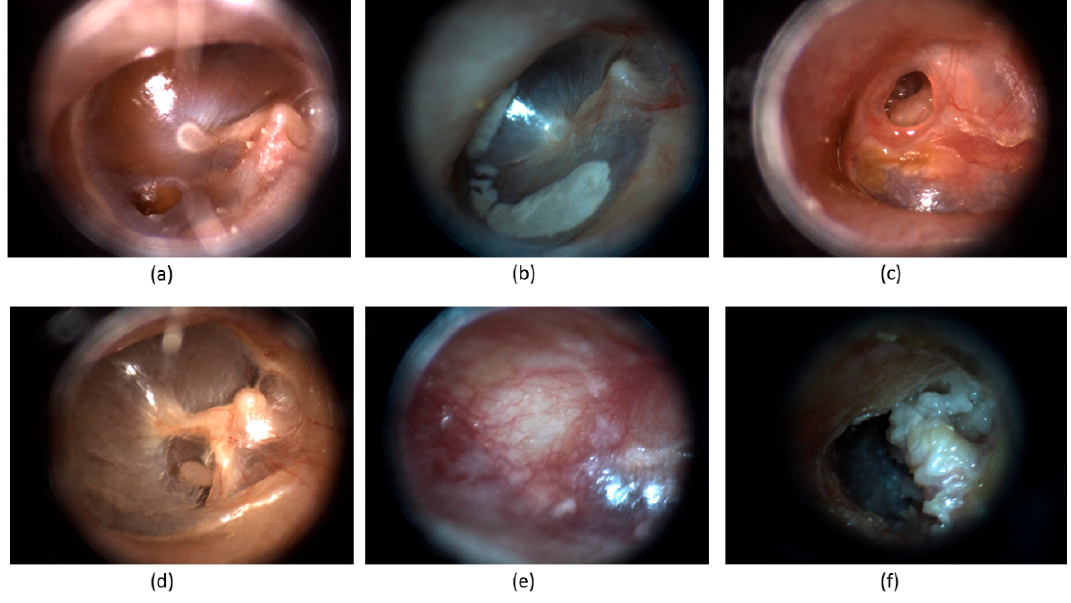
Figure 3. Examples of eardrum conditions observed in our dataset. The representative frame for each category was selected by a trained researcher: ( a ) otitis media with effusion, ( b ) tympanosclerosis, ( c ) eardrum perforation, ( d ) retraction, ( e ) acute otitis media (AOM), and ( f ) cholesteatoma.